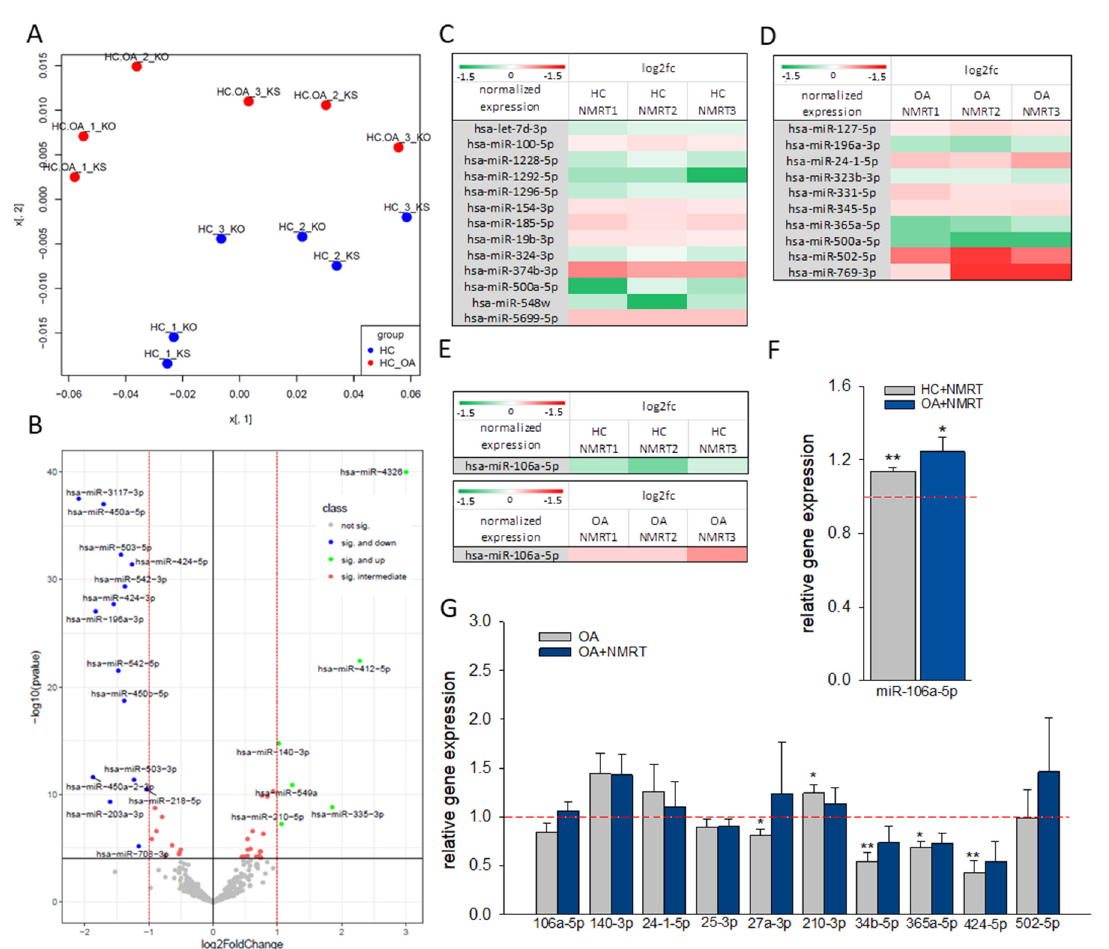
Figure 1. ( A ) Principal component analysis (PCA) based on all detected miRs of all tested samples distinguishes between healthy (HC) and OA chondrocytes; KO: untreated, KS: NMRT 5 h ( n = 3); x-axis: x[, 1] principle component 1; y-axis: x[, 2] principle component 2. ( B ) Volcano plot representing log2 fold change as a function of the adjusted p -value for miR expression in HC versus OA chondrocytes independent of the treatment procedure. The upregulated and downregulated miRs with the highest fold change are particularly designated. The log 1.5-fold change for direct NMRT effects on HC ( C ) or OA ( D ), and especially for miR-106a ( E ) is presented in heat maps with significance of changes at least at the p < 0.05 level (Student’s t -test). The direct effect of NMRT on HC (grey bars) and OA cells (blue bar) concerning miR-106 expression is depicted ( F ) (untreated cells as calibrator). The bar chart represents the relative gene expression of miRNAs affected under OA and involved in NF-kB signaling by attempting the comparison of HC and OA cells (grey bars); the blue bars present NMRT induced reversed effects when HC cells were compared with OA cells (blue bars) ( G ); in both cases HC cells functioned as calibrator. Data are mean ± SEM ( n = 5) are given; the Student’s t -test functioned as the statistical analysis. *: p < 0.05 and **: p <